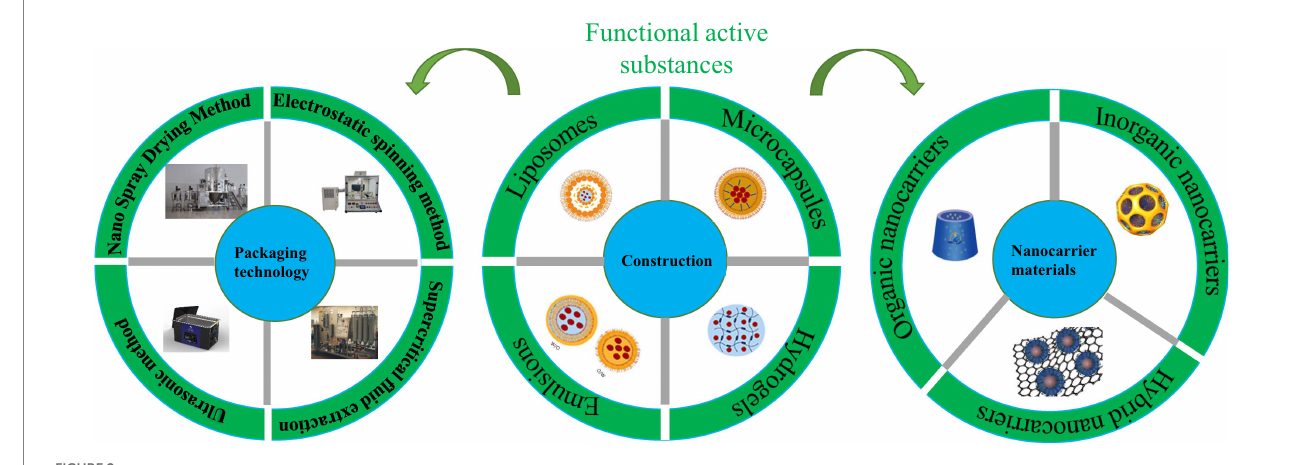
FIGURE 2 Construction of nano slow-release